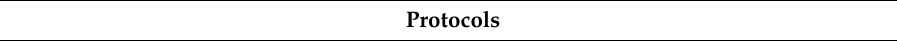
Table 3. Recommended MRI epilepsy